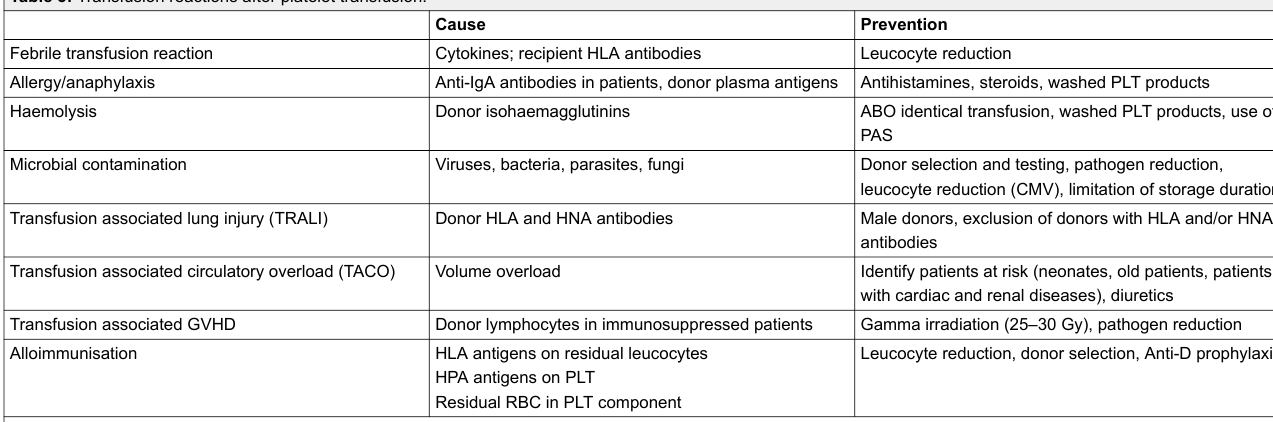
Table 3: Transfusion reactions after platelet